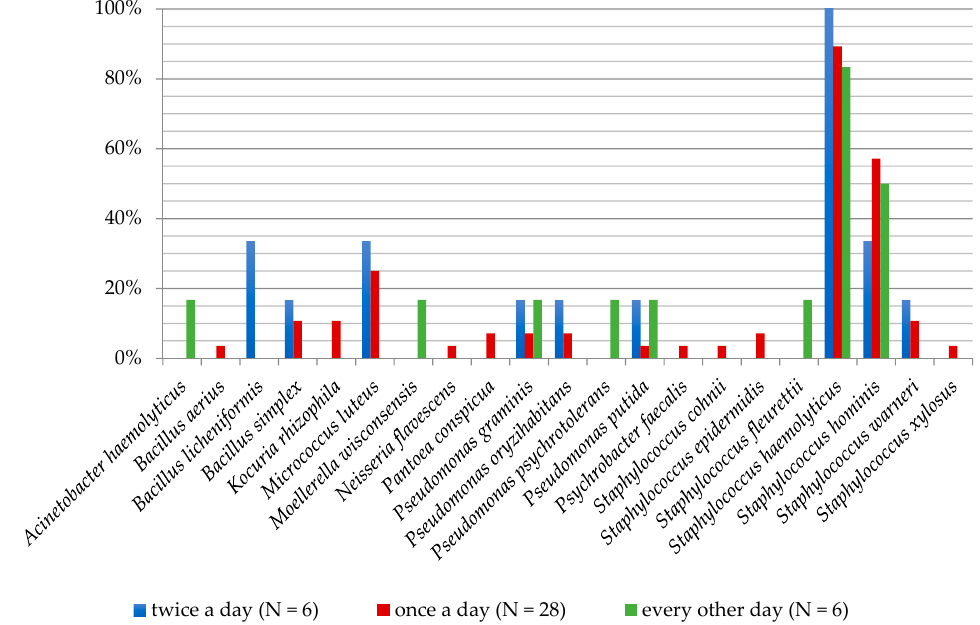
Figure 5. Frequency of the occurrence of bacteria on the foot skin depending on the washing feet frequency of examined people.